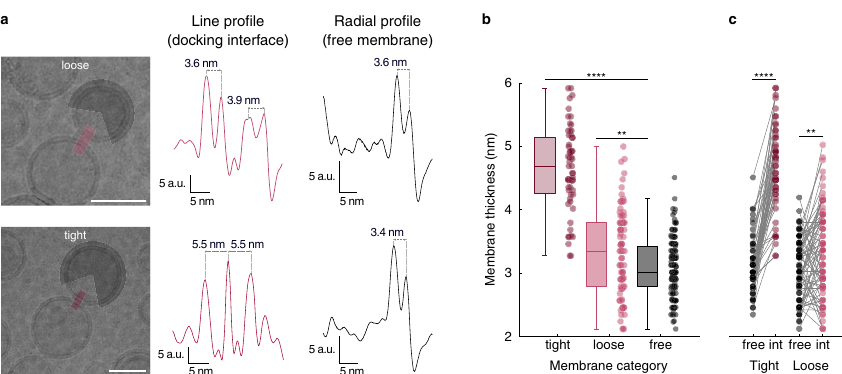
Fig. 3 Membrane thickening at tight docking interfaces. a Membrane thickness of loosely (top) and tightly (bottom) docked interfaces, measured by line scans (at the interfaces) and radial pro fi le analysis (membranes outside docking interfaces). Thickness is determined as distance between peaks corresponding to lipid headgroups between the two lea fl ets. Scale bars 50 nm. b Comparison of membrane thicknesses at tight ( n = 50), loose ( n = 72), and docking-free interfaces ( n = 122) obtained by analyzing cryoEM images as shown in a. Boxes represent interquartile range, and whiskers below and above indicate full data range. Line in a box represents median. Data were analyzed with a one-tailed unpaired t -test at α = 0.05, **** P < 0.0001; ** P = 0.0015. c Membrane thickness variations within single membranes being involved in docking interfaces (int) or free ( n Tight = 50; n Loose = 72). Data were analyzed with the Wilcoxon matched-pairs signed-ranks test at α = 0.05, **** P < 0.0001; ** P = 0.006. Source data are provided as a Source Data fi